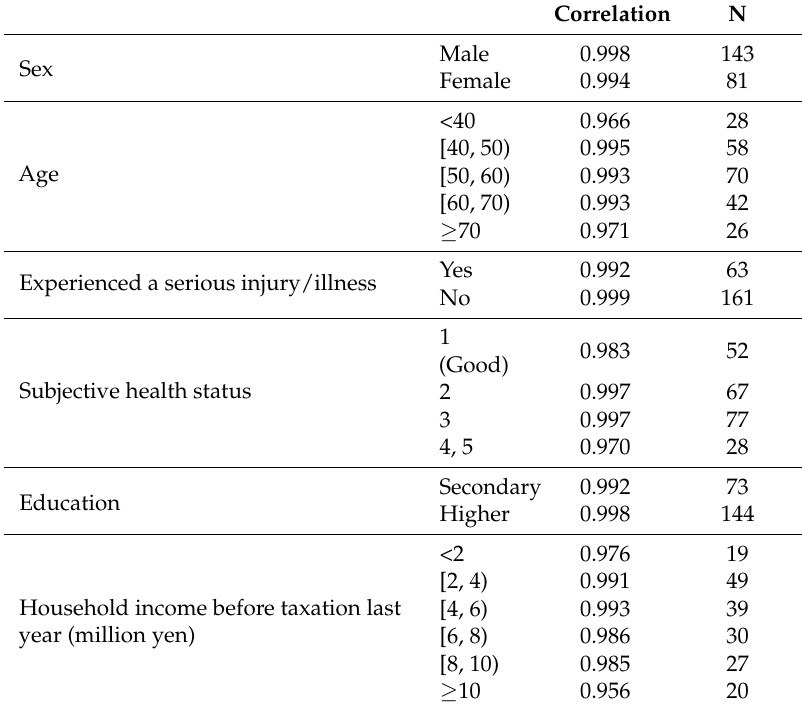
Table 3. Correlations of Disablement Scores between Subgroups and the Entire Sample.